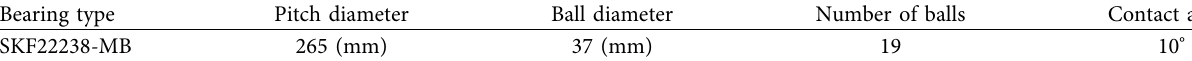
Table 3: Experimental bearing data parameters.